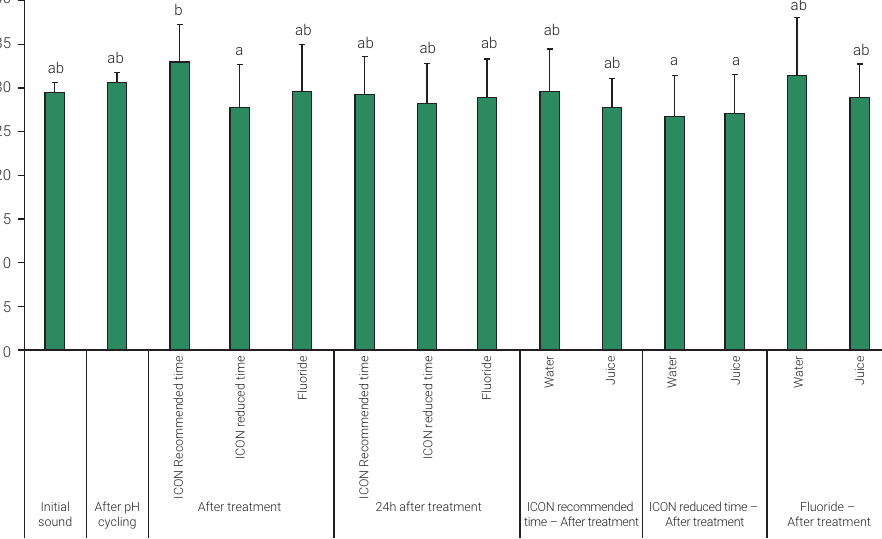
Figure 3. Graphic representation of b* mean values and standard deviations. Different letters indicate statistical significant difference (p <